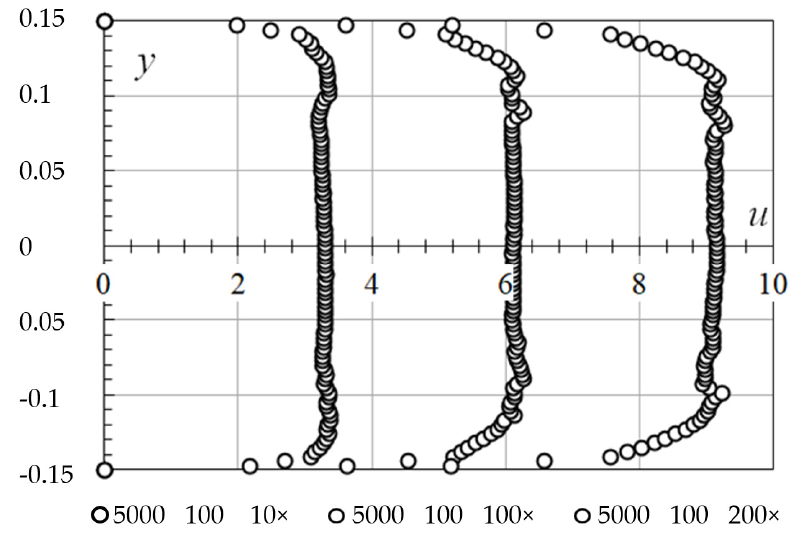
Figure 3. Air velocity profiles in the vertical central-section ZOY at 100 kg/h ( y [m], u [m/s]), curves from left to right, respectively: 10×; 100×; 200×.